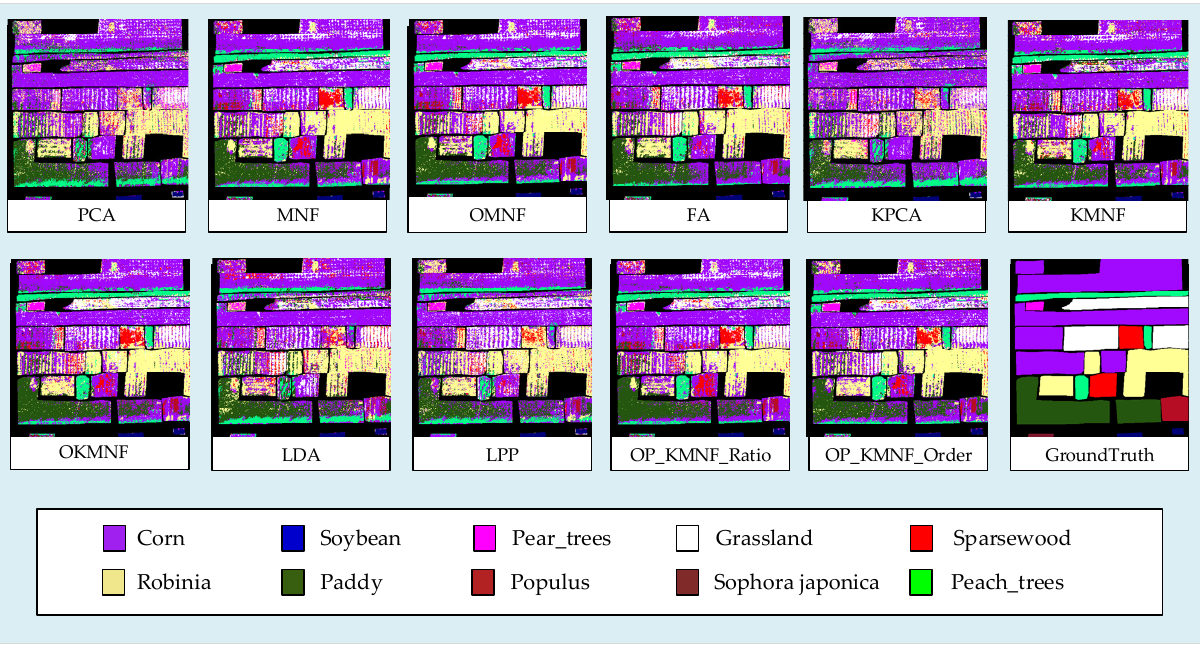
Figure 10. The SVM classification results of Xiong’an after different DR methods (number of features = 5).